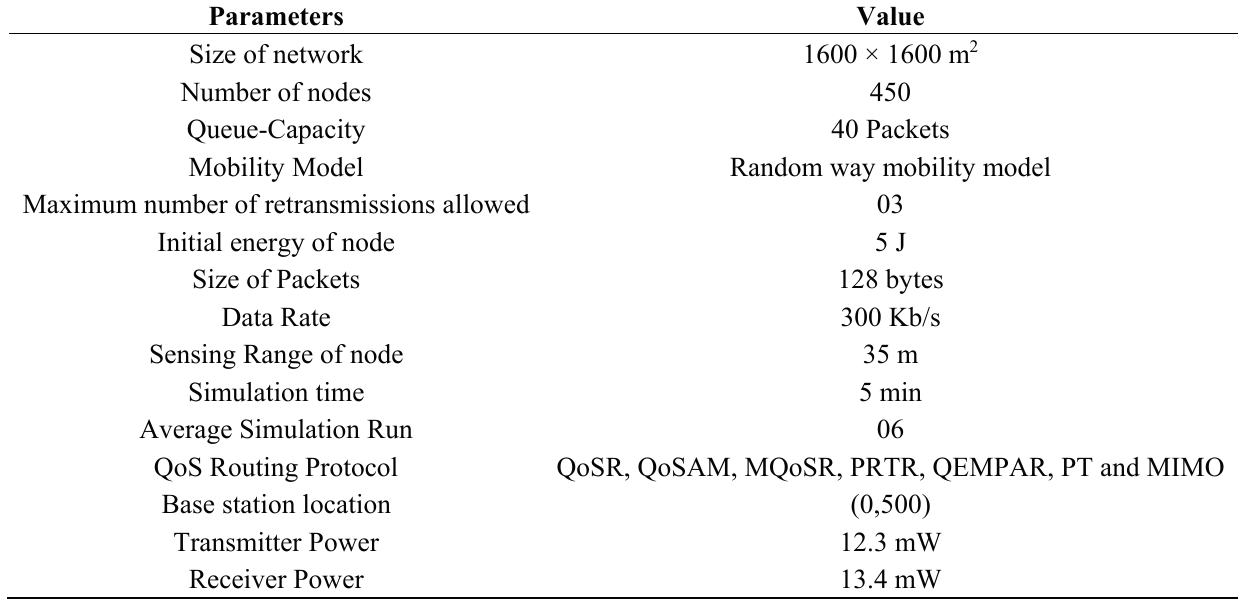
Table 1. Simulation parameters and its corresponding